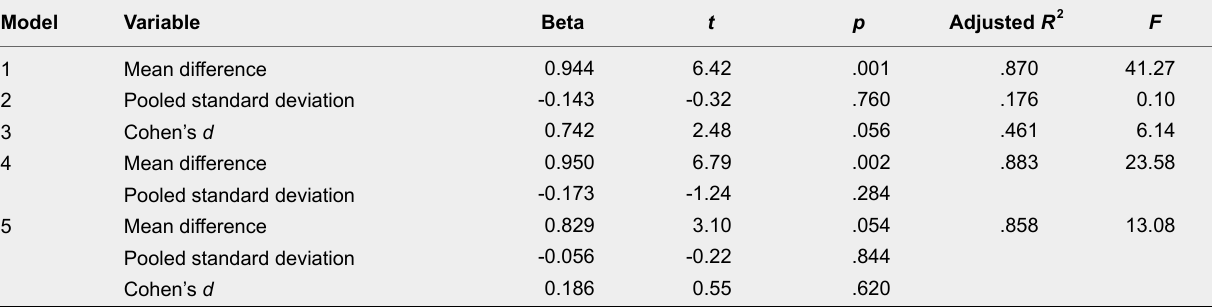
Results of the Multiple Regression Analyses on Average Ratings in Experiment 1